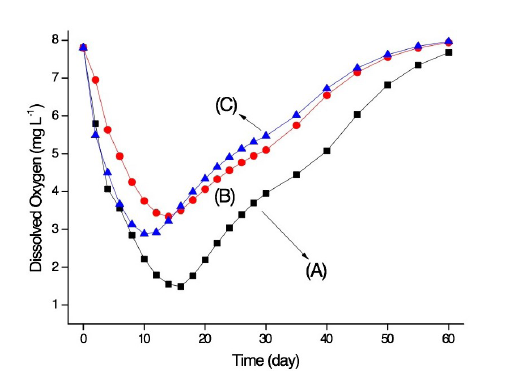
Figure 1. Simulations of the dissolved oxygen concentrations during the filling of a new reservoir in 3 hypothetical scenarios. Where: scenario (A) without deforestation and a given constant; scenario (B) deforestation of 68% of the savanna and constant flow; scenario (C) deforestation of 68% of the savanna and variable flow during the filling (according to a given proposal of operative rule). Bianchini Junior & Cunha-Santino